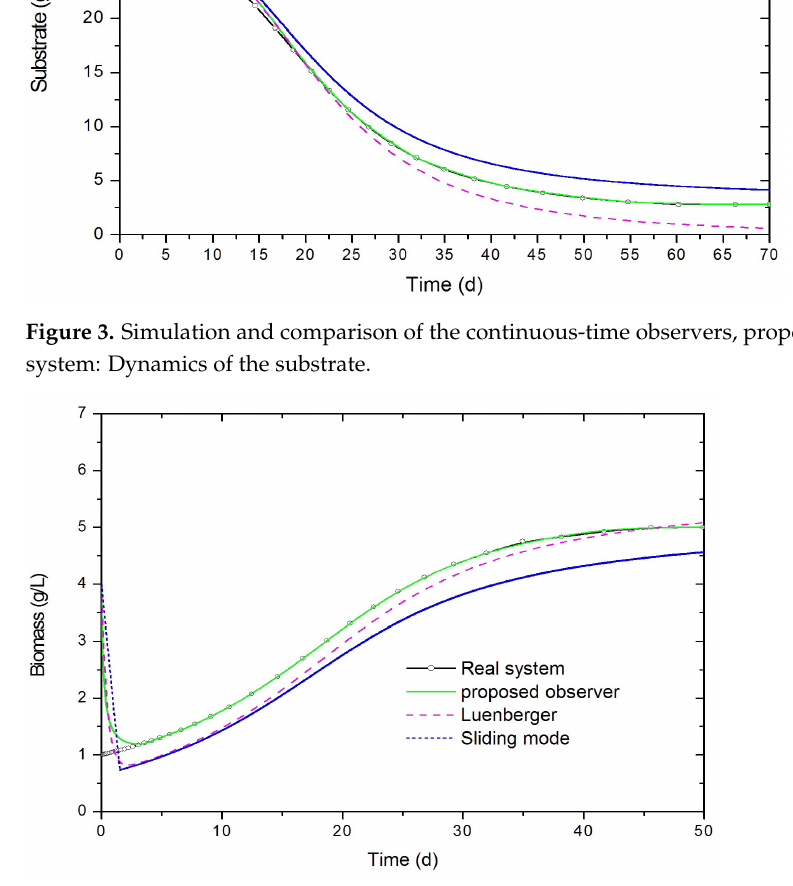
Figure 4. Simulation and comparison of the continuous-time observers, proposed observer vs. real system: Dynamics of the biomass.